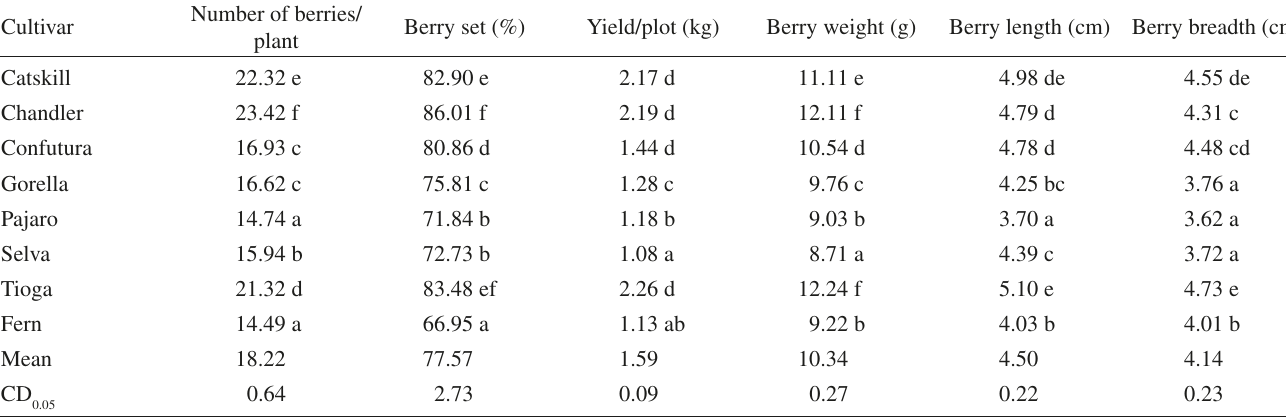
Table 2 - Yield and fruiting characters of strawberry cultivars under polyhouse Number of berries/ Cultivar Berry set (%) Yield/plot (kg) Berry weight (g) Berry length (cm) Berry breadth (cm) plant Catskill Chandler Confutura